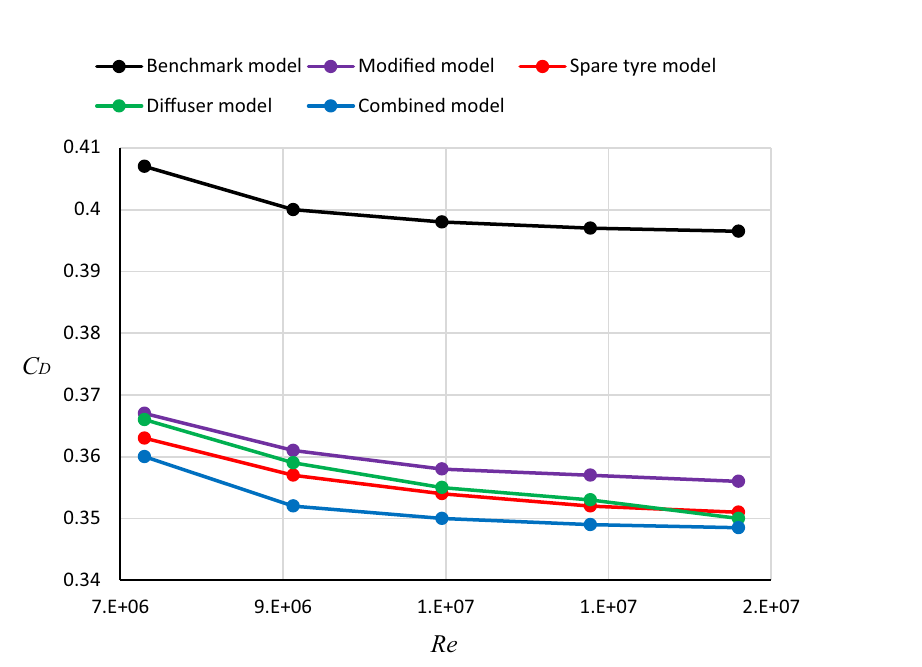
Figure 13. Relation between C D and Re for many configurations of the